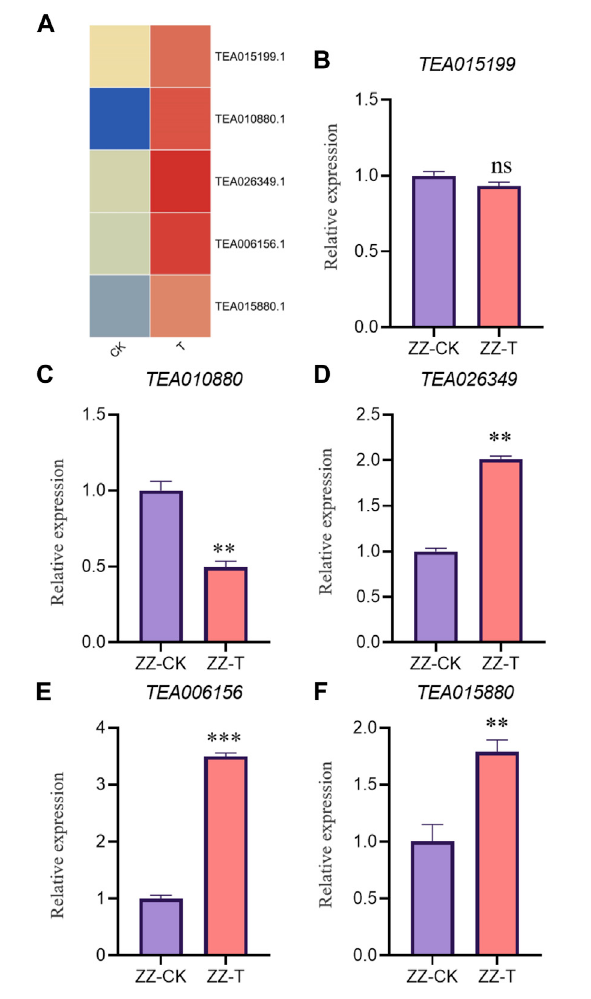
FIGURE 10 | ZZ-CK&ZZ-T Comparison of unregulated genes expression pattern between RNA-Seq and qRT-PCR results. The gene expression values were normalized to the Actin gene. The purple column represents the results of drought treatment for 0 days, and the orange red column represents the results of drought treatment for 20 days. CK: Seedingsamplestreated withdrought for 0 days,T: Seeding samples treated with drought for 20 days. ** p < 0.01, *** p <